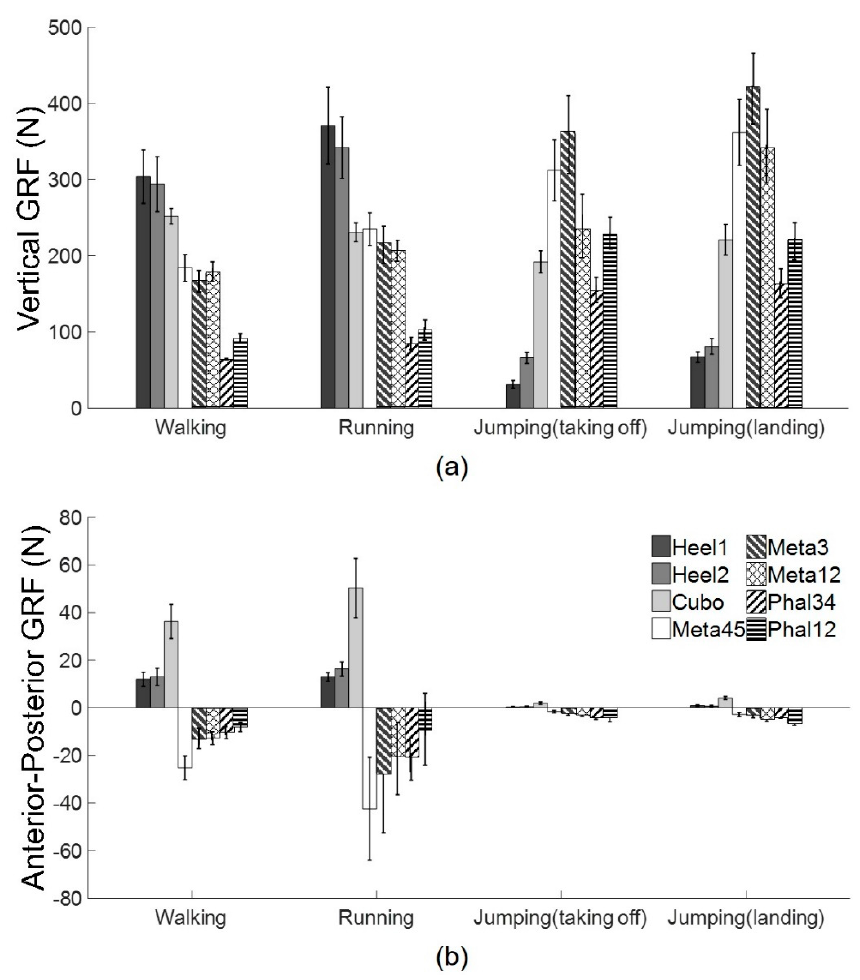
Figure 10. ( a ) Mean and standard deviation of peak vGRF measured by each custom force sensor